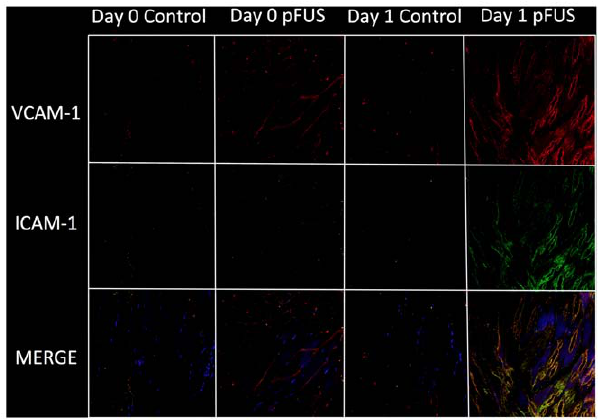
Figure 9. Expression of ICAM-1 and VCAM-1 in muscle tissue on days 0 and 1 following pFUS. Blue represents DAPI stained nuclei, green represents ICAM-1, red represents VCAM-1, and yellow represents merged ICAM-1 and VCAM-1. Compared to control, there is slight increase of VCAM-1 on day 0 and dramatic increase of both ICAM- 1 and VCAM-1 on day 1 post-pFUS.